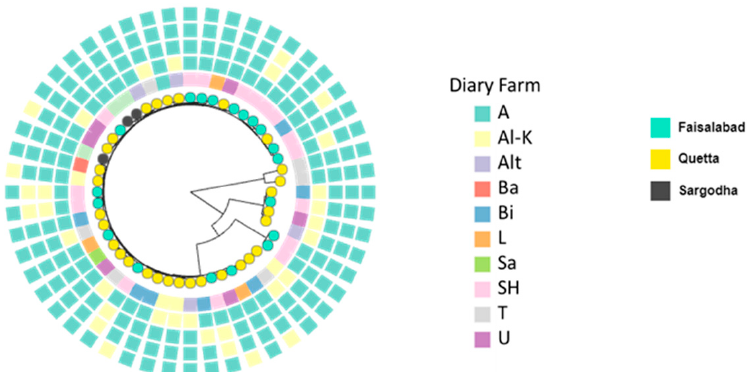
Figure 3. Distribution of the four most common plasmids in the Klebsiella isolates. The nodes indicate the region of origin (green = Faisalabad, yellow = Quetta, black = Sargodha). The inner ring indicates the specific dairy farm (legend). The next four rings indicate the presence of specific plasmids (yellow = present, green = absent). Moving outwards from the second ring, the plasmids are: CP009275, CP011627, CP013713, CP011633. The distribution of all 71 plasmids in the dataset is provided in Supplementary Figures S3 and